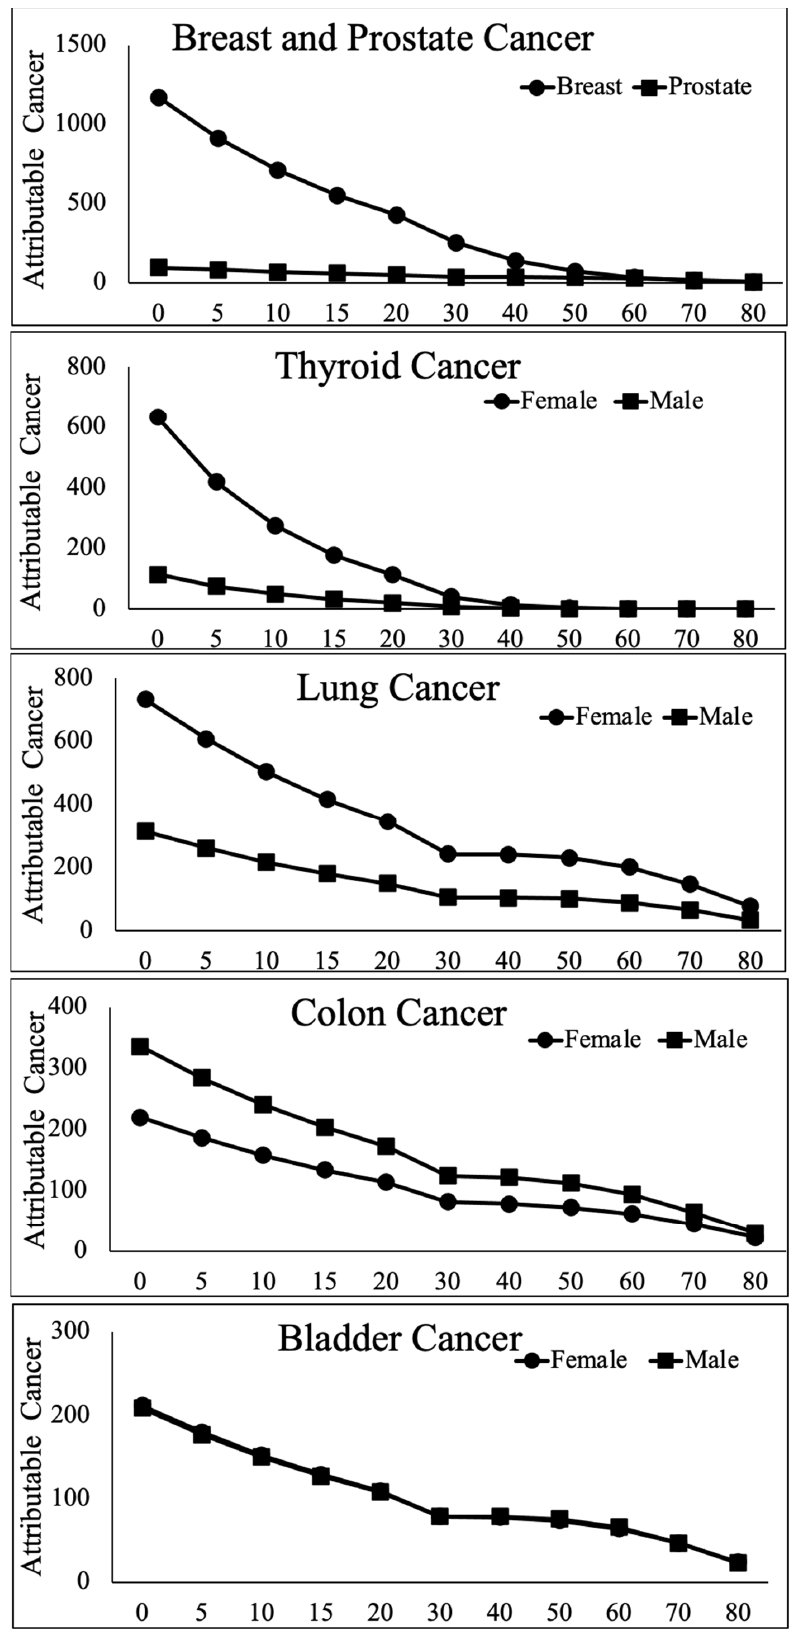
Figure 1. Cancers attributable to radiation exposure vary by organ, sex and age at exposure. Y axis: attributable cancer cases/100,000 persons/0.1 Gy. X axis: Age at exposure in years. Derived from